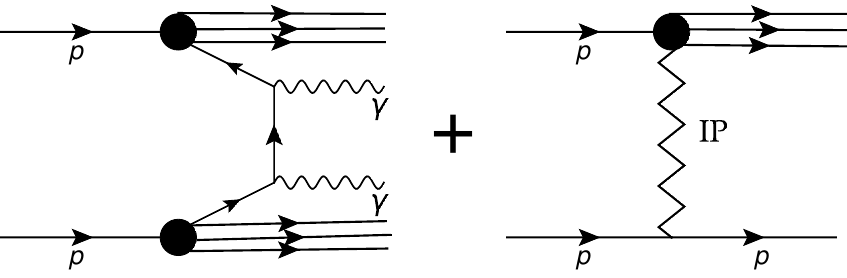
Figure 3 . The dominant background for central exclusive diphoton production comes from non- exclusive photon pair production (left) overlapped with uncorrelated protons coming from soft di(cid:11)ractive processes in the additional interactions per bunch crossing